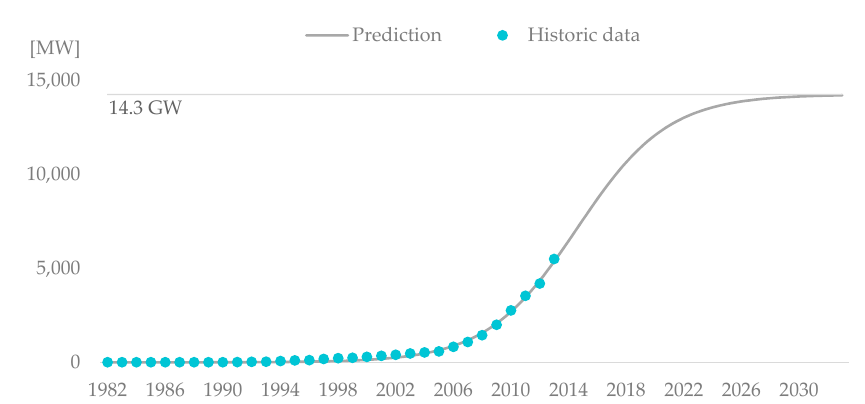
Figure 3. Prognosis of wind power development in Sweden between 1982 and 2034, as calculated by Equation (5). Historic data over installed capacity between 1982 and 2014 (used to assume suitable intercept- and scaling factors) is shown as blue dots.